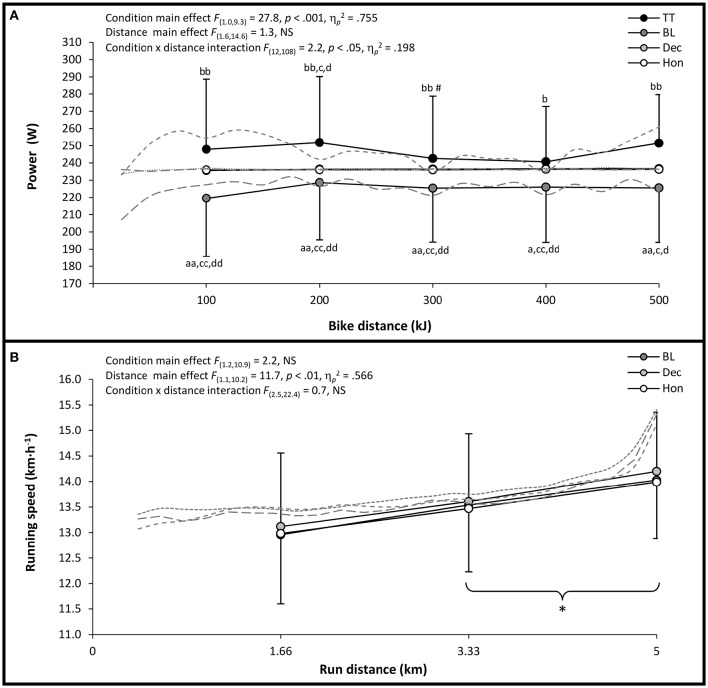
(A) Mean ± SD power output for each 100 kJ (solid lines) and 25 kJ (dashed lines) completed in each cycling condition, (B) Mean running speed for each 1.66 km (solid lines) and 200m (dashed lines) section completed in each triathlon trial. Significantly different from; TT, ap < 0.05,aap < 0.01; BL, bp < 0.05, bbp < 0.01; DEC, cp < 0.05, ccp < 0.01; HON, dp < 0.05, ddp < 0.01; initial value, *p < 0.05; previous value, #p < 0.05, (parentheses indicate significance in all conditions).